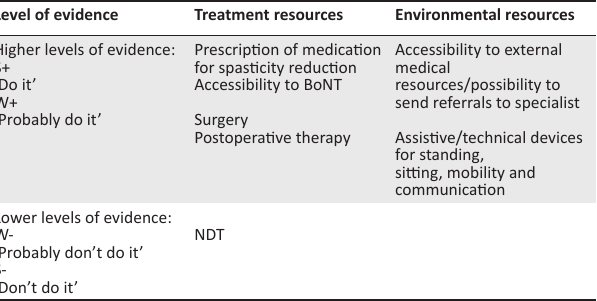
TABLE 6: Additional treatment and environmental resources that professionals perceived as needed to obtain and secure a satisfactory pain management for children with cerebral palsy related to the levels of the evidence of interventions for children with cerebral palsy as reported by Novak et al.